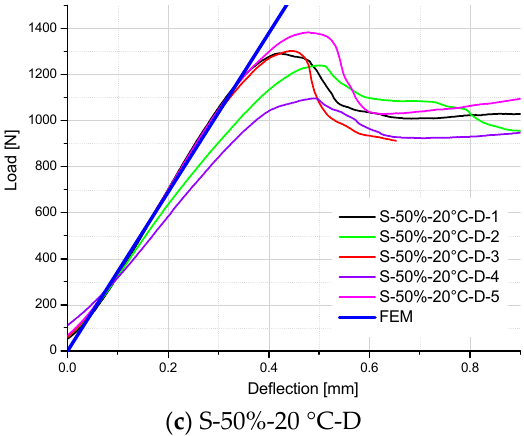
Figure 14. Comparison of load–deflection curves between FE analysis and test results of specimens tested at 20 °C and in the moisture desorption process.